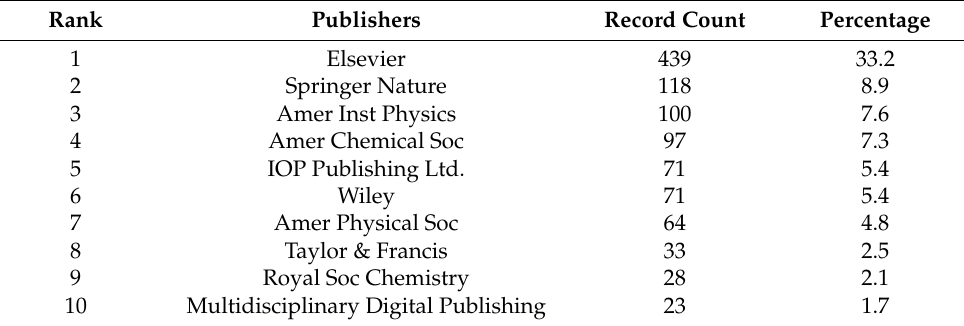
Table 3. Top 10 most active publishers on fractal theory in thin